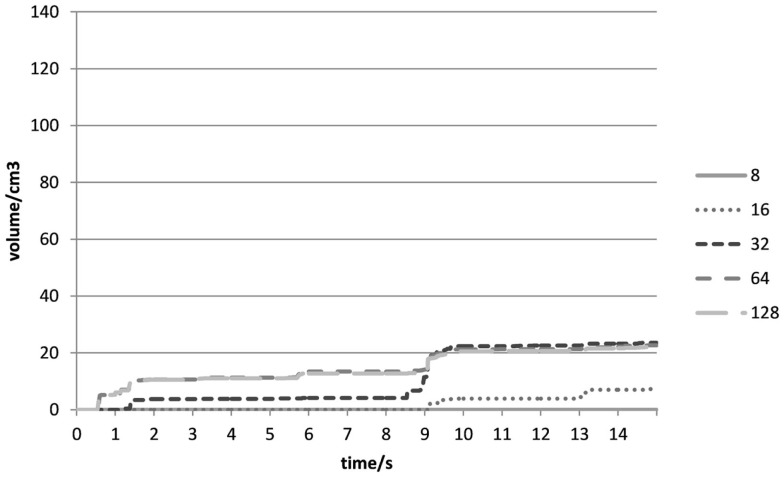
Type I volumetric errors (cm3) over time (s) for different voxel resolutions in Experiment 1.